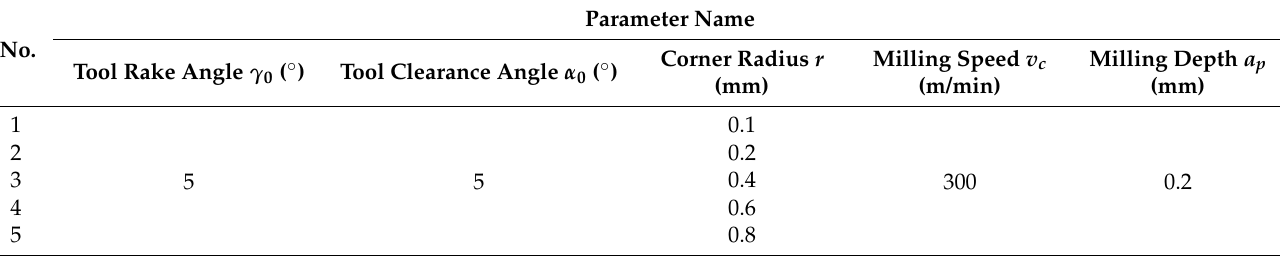
Table 6. Single-factor analysis scheme of different corner radii.